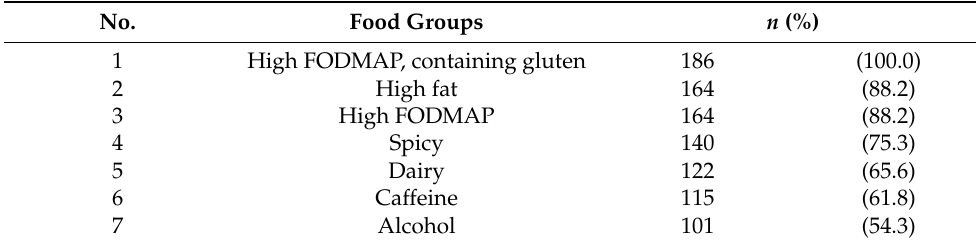
Table 4. Food groups causing IBS